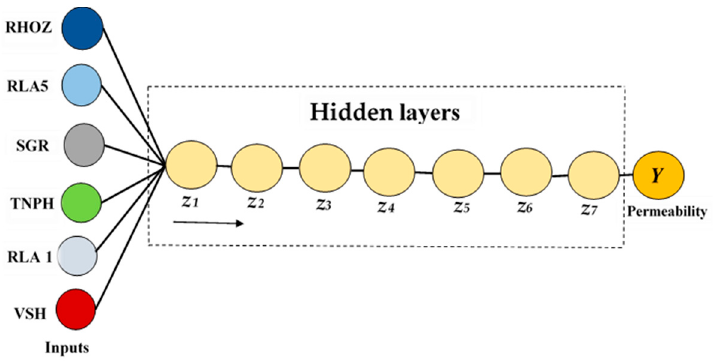
Figure 6. Illustration of the proposed GMDH-type neural network.